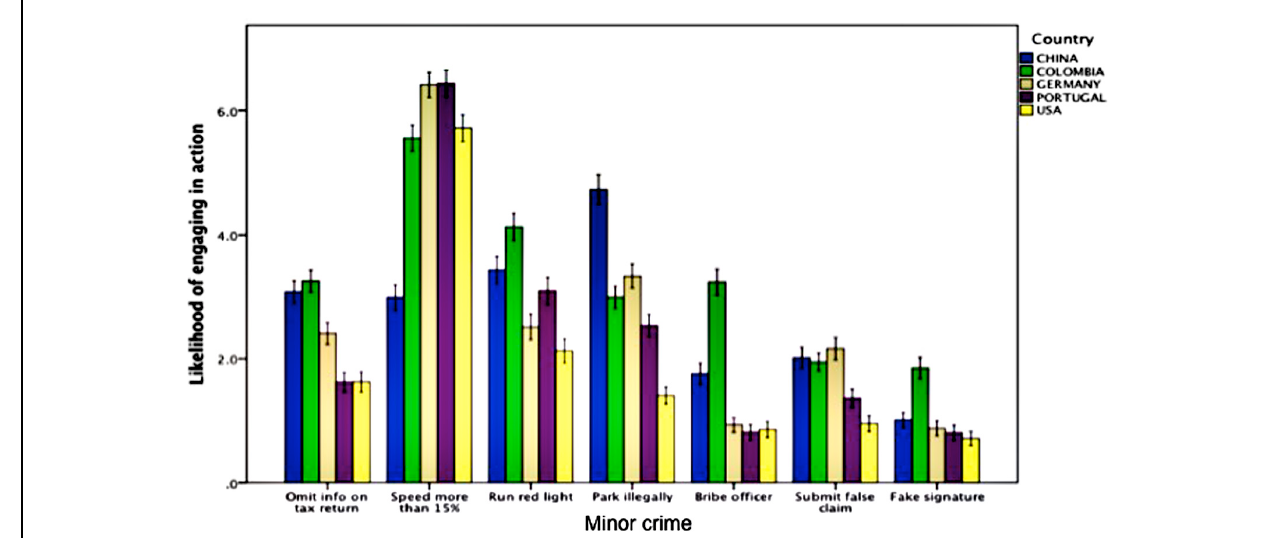
FIGURE 1 | Self-reported likelihood of engaging in seven specific dishonest actions across countries. Error bars represent ± 1 SEM.